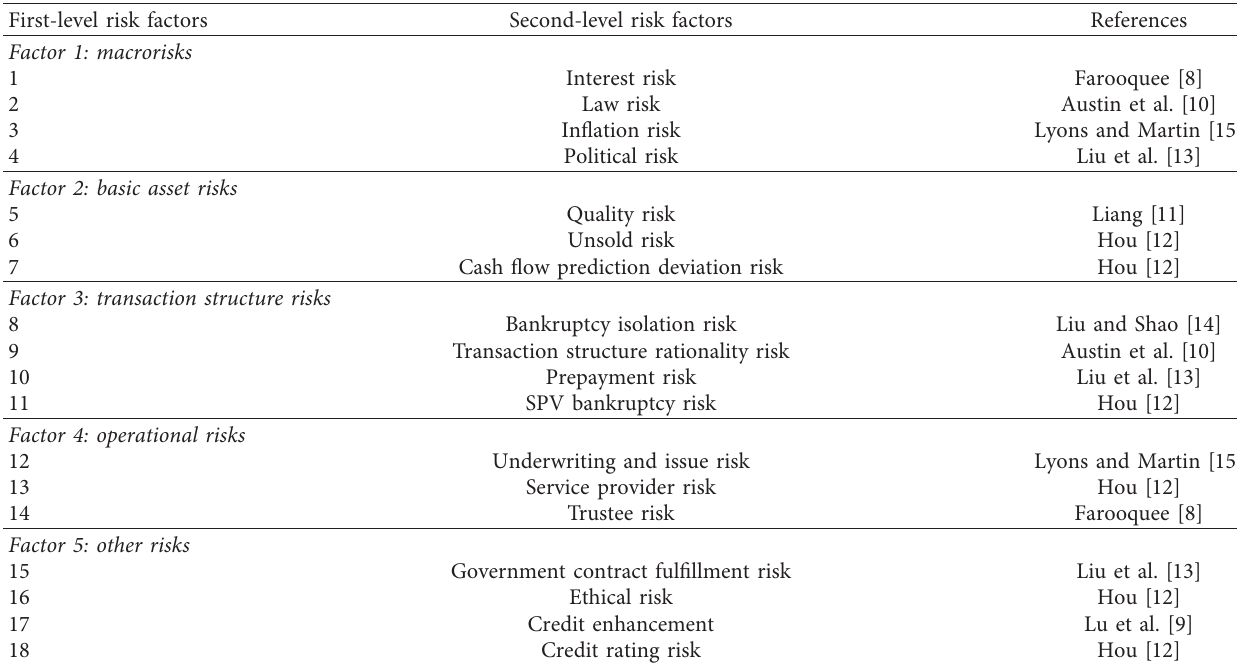
Figure 1: Research framework. Table 1: Initial risk system of the sewage treatment PPPABS